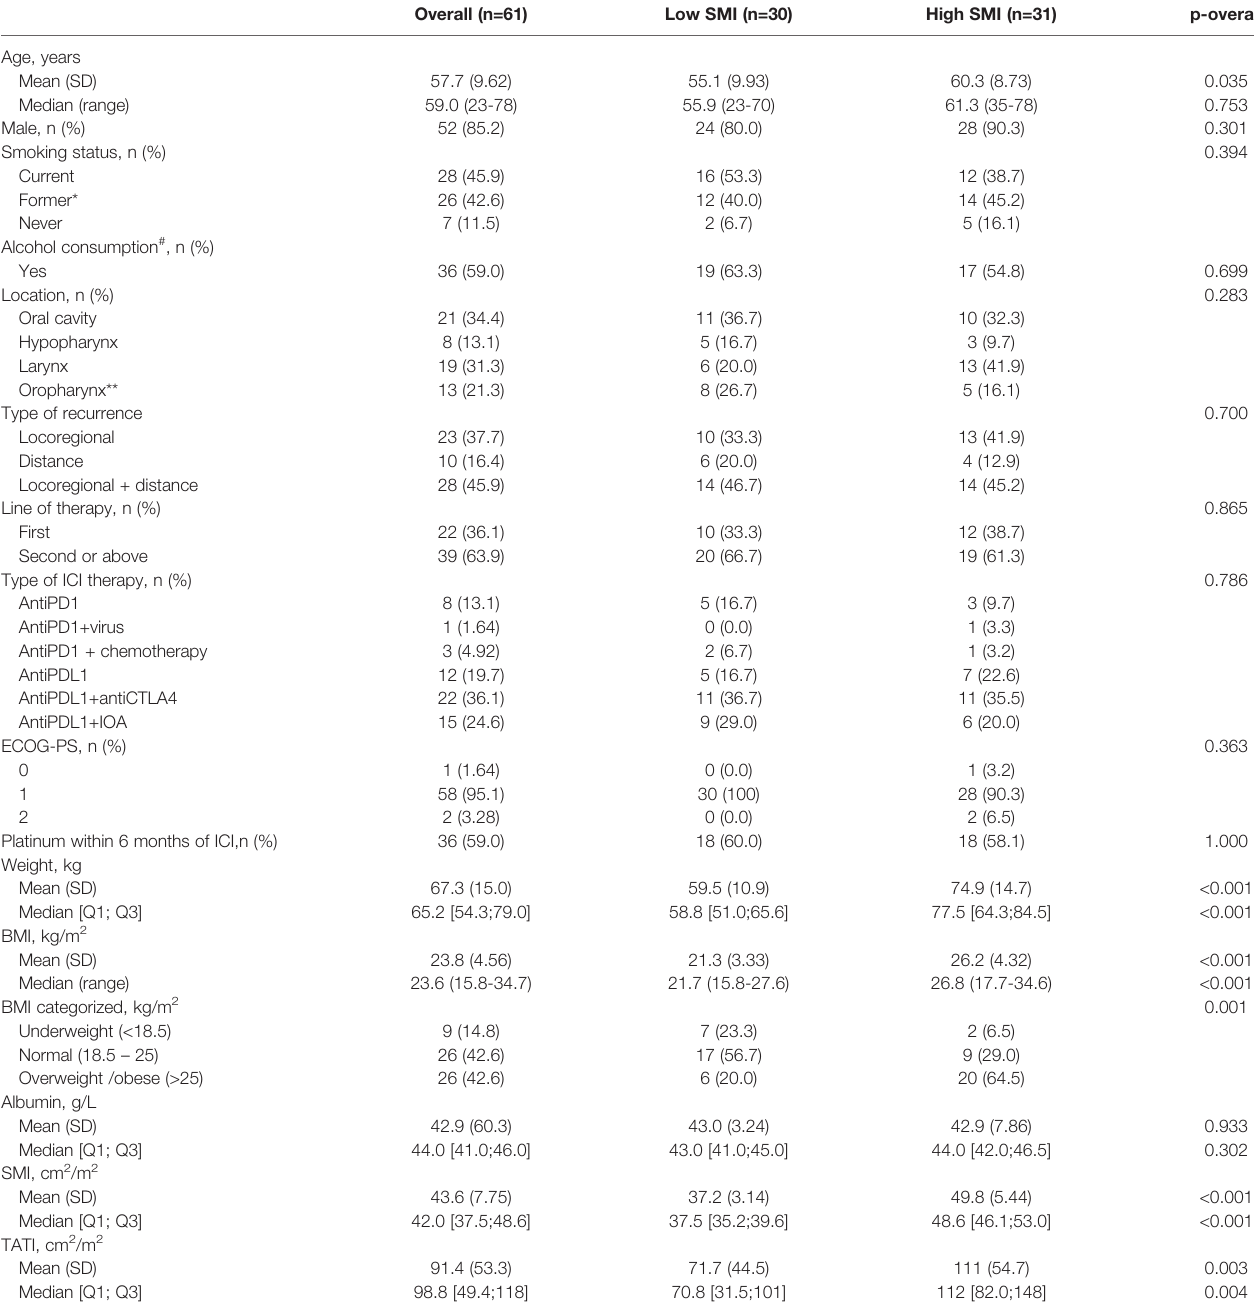
TABLE 1 | Patient baseline characteristics (overall and according to low vs high skeletal muscle index) (SMI)